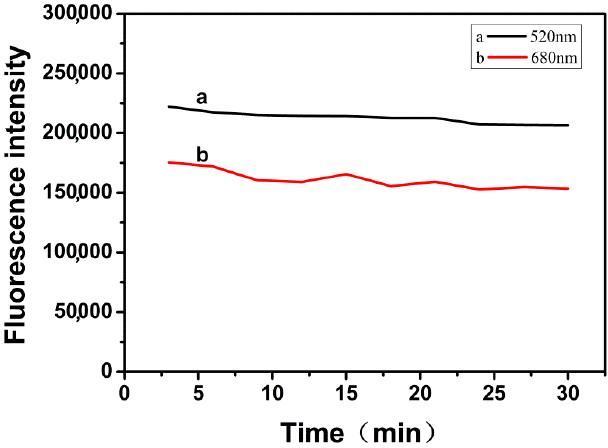
Figure 3. The fluorescence intensity of the RFN under 30 min.